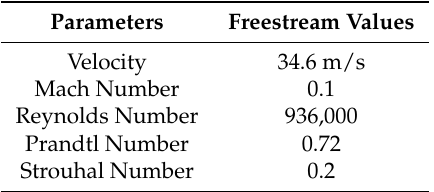
Table 1. Prescribed numerical